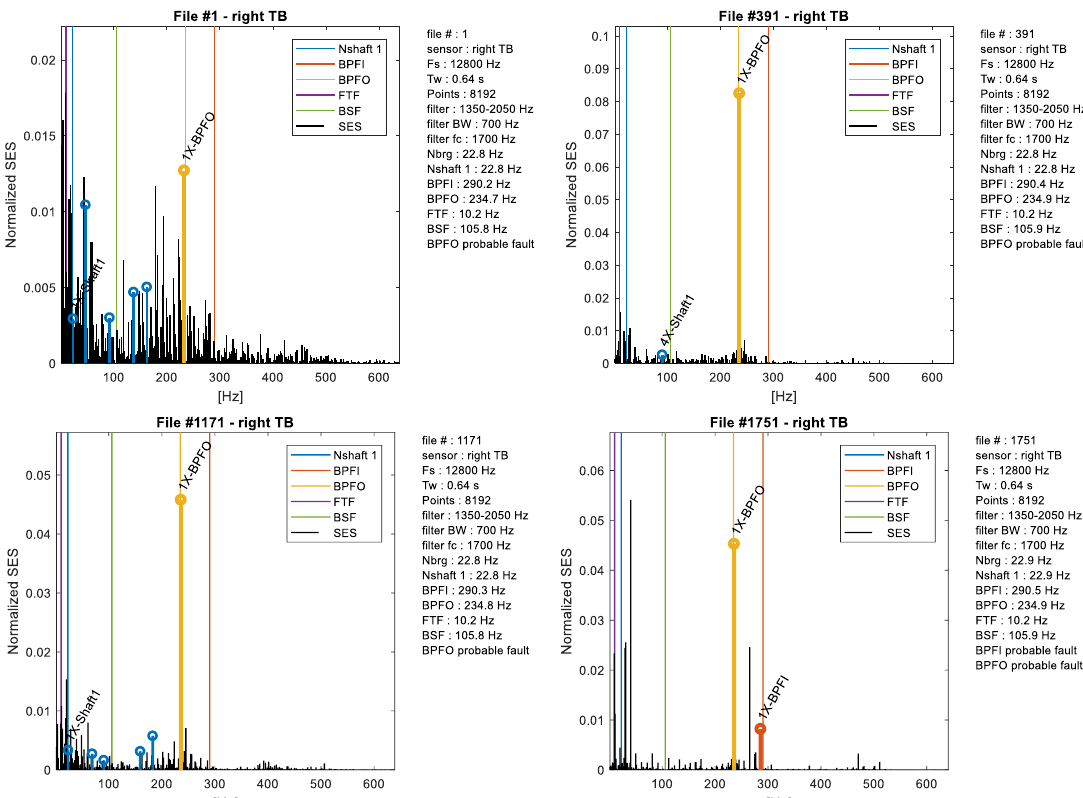
Figure 16. Values of the normalized SES for some data records, first frequency band—right TB.